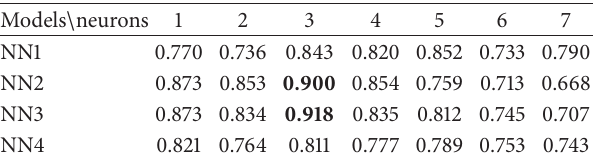
Table 2: Performance ( 𝑅 2 ) of NN models with different neurons in the hidden layer.